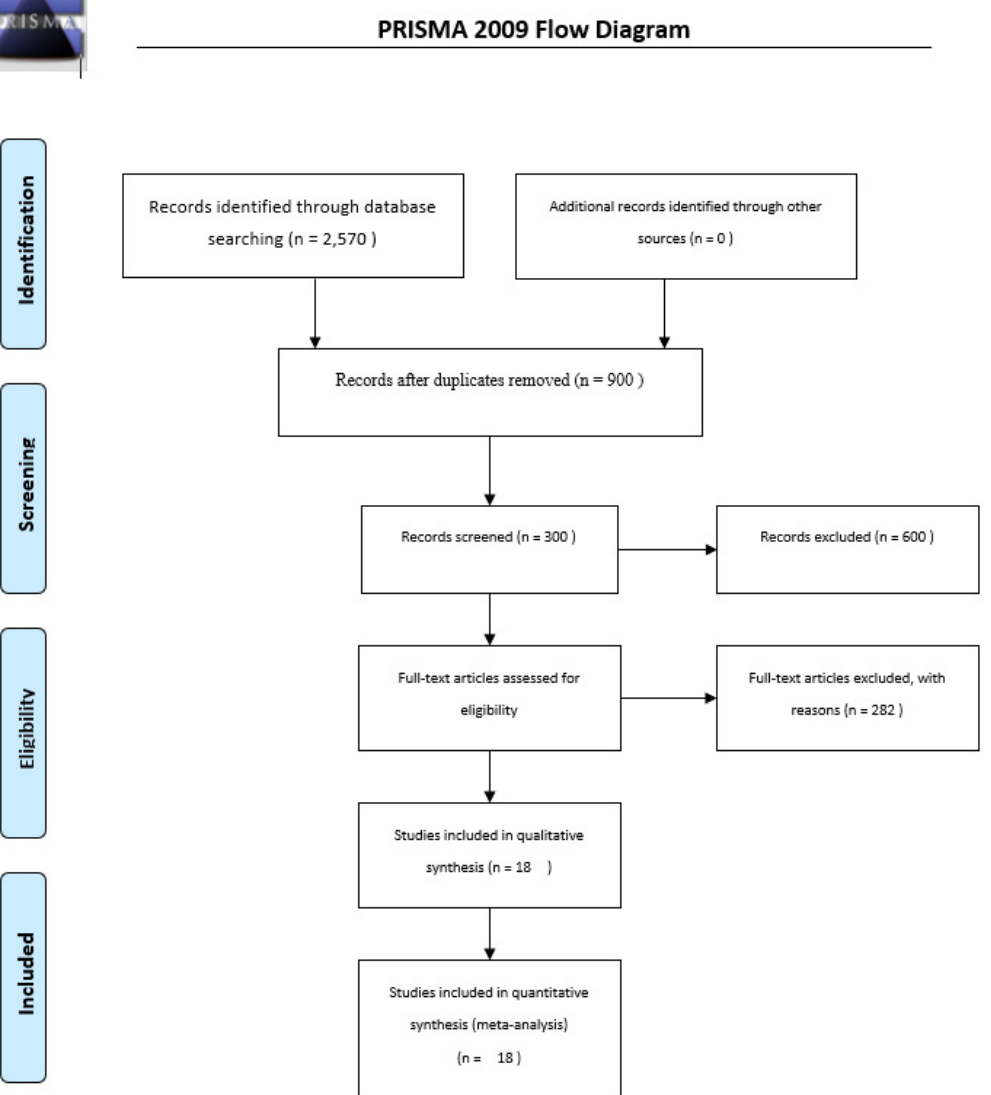
Figure 1. The process of studies retrieval and inclusion adopted in the present systematic review and meta-analysis.